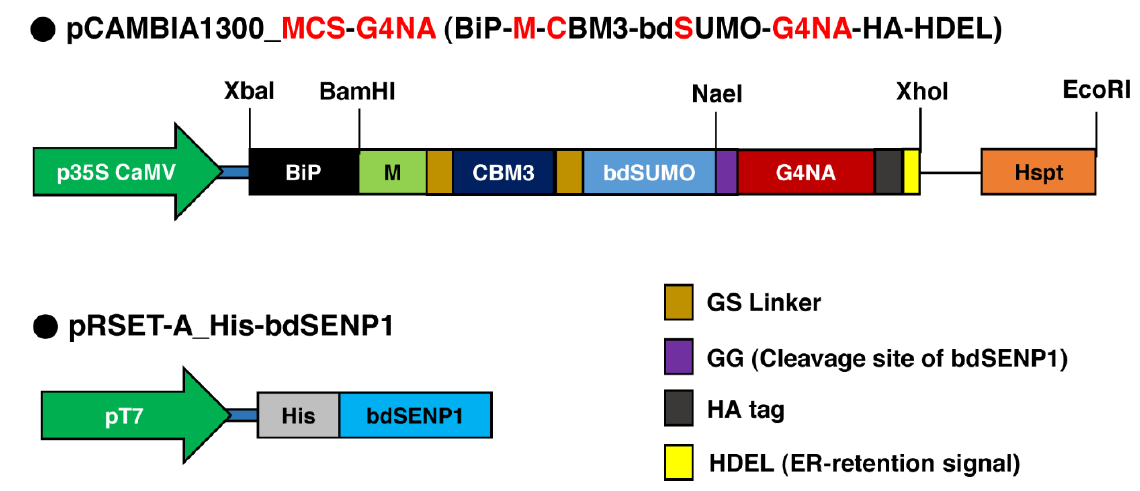
Figure 1. Schematic representation of MCS-G4NA construct. BiP, the signal sequence of BiP; M, the extracellular domain (amino acid residues 231–290) of human protein tyrosine phosphatase receptor type C; CBM3, the cellulose-binding module 3 of Clostridium thermocellum ; bdSUMO, the SUMO domain of Brachypodium distachyon ; and HDEL, ER retention signal.